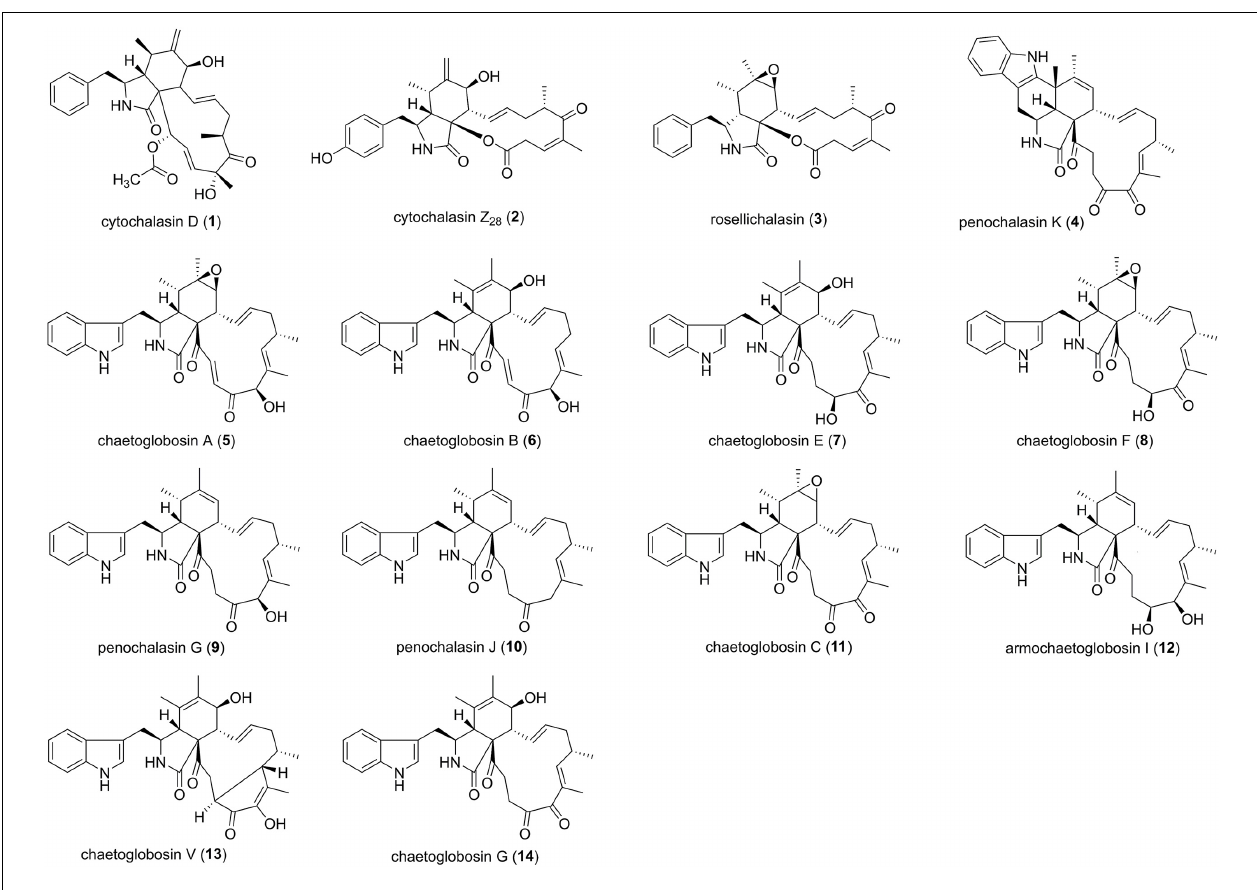
FIGURE 1 | Cytochalasin alkaloids characterized from endophytic fungi